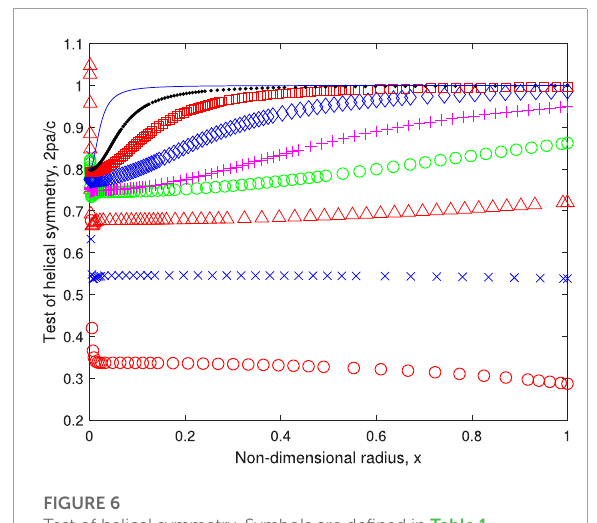
FIGURE 5 The circumferential velocity at the rotor. Symbols are defined in